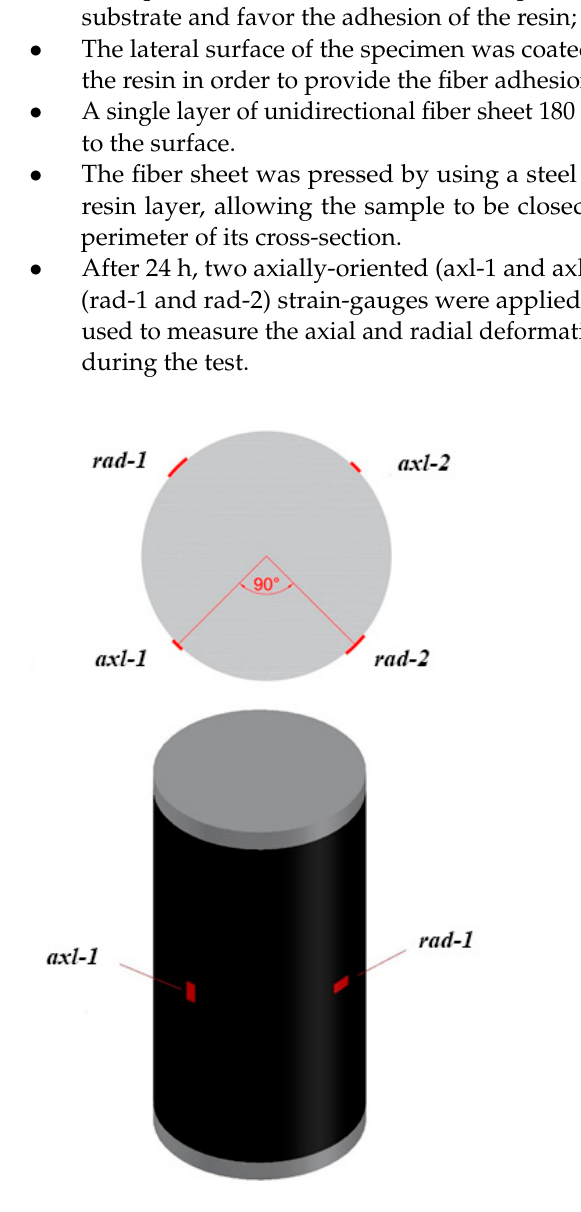
Figure 3. Strain gauges equipment layout.